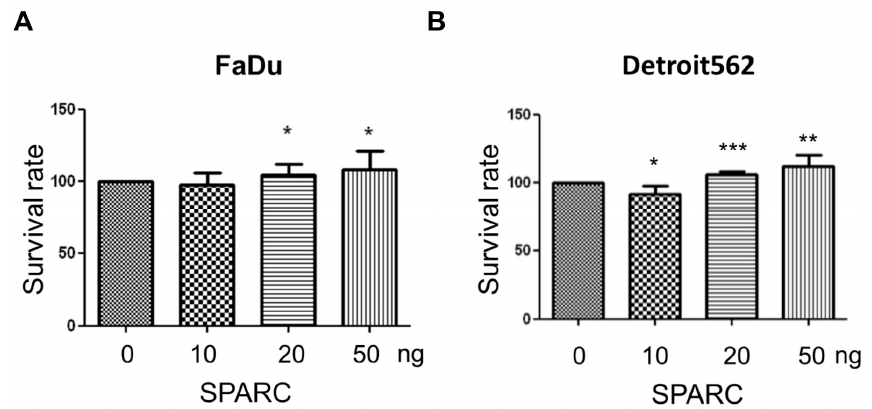
Figure 1. Secreted protein acidic and rich in cysteine (SPARC) treatment promoted cell proliferation. ( A ) FaDu and ( B ) Detroit 562. The error bars represent standard deviation (SD) ( t -test; * p < 0.05, ** p < 0.01, *** p < 0.001, when compared with 0 ng